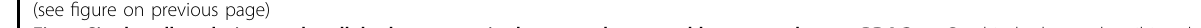
Fig. 1 Single-cell analysis reveals cellular heterogeneity between dense- and loose-type human PDACs. a Graphical scheme describing the work fl ow. Nine human PDAC samples with dense or loose stroma, as well as one adjacent normal sample were dissociated into single cells followed by scRNA-seq using the 10× Genomic platform. Public scRNA-seq data from four PDAC and two normal tissues were included for comparison and joint analyses. b Representative H&E and Masson staining of four dense- and three loose-type PDAC tumors. Yellow arrow, cancer cell; Black arrow, stroma. c Unsupervised clustering of viable cells from nine human PDAC tumors, one adjacent normal sample, and six samples from public data, represented as UMAP plots. Twenty clusters and eight cell types were identi fi ed. The cell proportions from dense- and loose-type PDACs are listed. d Bubble plot showing selection of cell type-speci fi c markers across major clusters. The size of the dot indicates the fraction of cells expressing a particular marker, and the intensity of the color represents the level of mean expression. e Immuno fl uorescence staining was used to con fi rm the changes in the proportion of different cell types in dense- and loose-type PDACs. Nine PDAC samples undergoing scRNA-Seq were stained with indicated antibodies (anti-COL1A1 for pan-CAF, anti-CD3 for T cell, anti-CK19 for epithelial cell, anti-CD68 for macrophage). Representative fi gures are shown. The results show that there are more in fi ltrating macrophages and T cells in loose-type PDAC than in